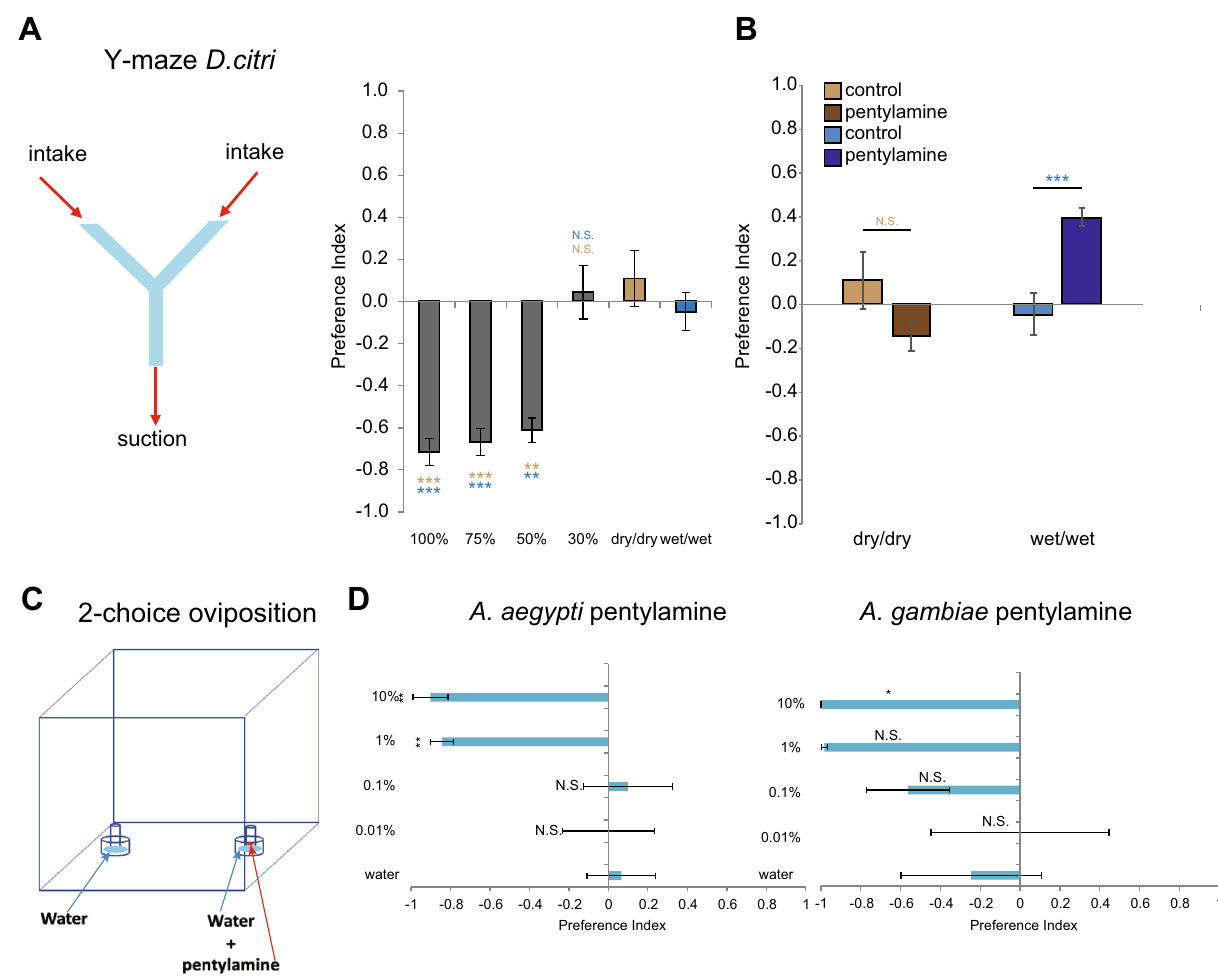
Figure 3. ( A ) Schematic drawing of the Y-maze used for ACP two-choice behavioral assays. Behavioral preference index of ACP to humid air at the indicated concentrations versus dry air, and dry air (dry/dry) or moist air at 75% (wet/wet) pumped into both arms as controls. N = 5–12 trials of 20 male psyllids for each dose. Error bars indicate s.e.m.; ** p < 0.01; *** p < 0.001. ( B ) Behavioral preference index of ACP to dry air (dry/ dry, Left) or moist air at 75% (wet/wet, Right) pumped into both arms as controls and wet or dry air versus wet or dry air with 1% pentylamine. n = 6–12 trials of 20 male psyllids for each humidity level. Error bars indicate s.e.m.; *** p < 0.001. ( C ) Schematic representation of two-choice mosquito oviposition assay. ( D ) Left. Oviposition preference index in Aedes aegypti mosquitoes to the indicated concentration of pentylamine versus water alone. n = 4–6 trials with 15 mosquitoes per trial. Error bars represent s.e.m. * p < 0.05. Right. Oviposition preference index in Anopheles mosquitoes to the indicated concentration of pentylamine versus water alone. n = 4 and 6 trials respectively, with 15 mosquitoes/trial. Error bars represent s.e.m. * p <